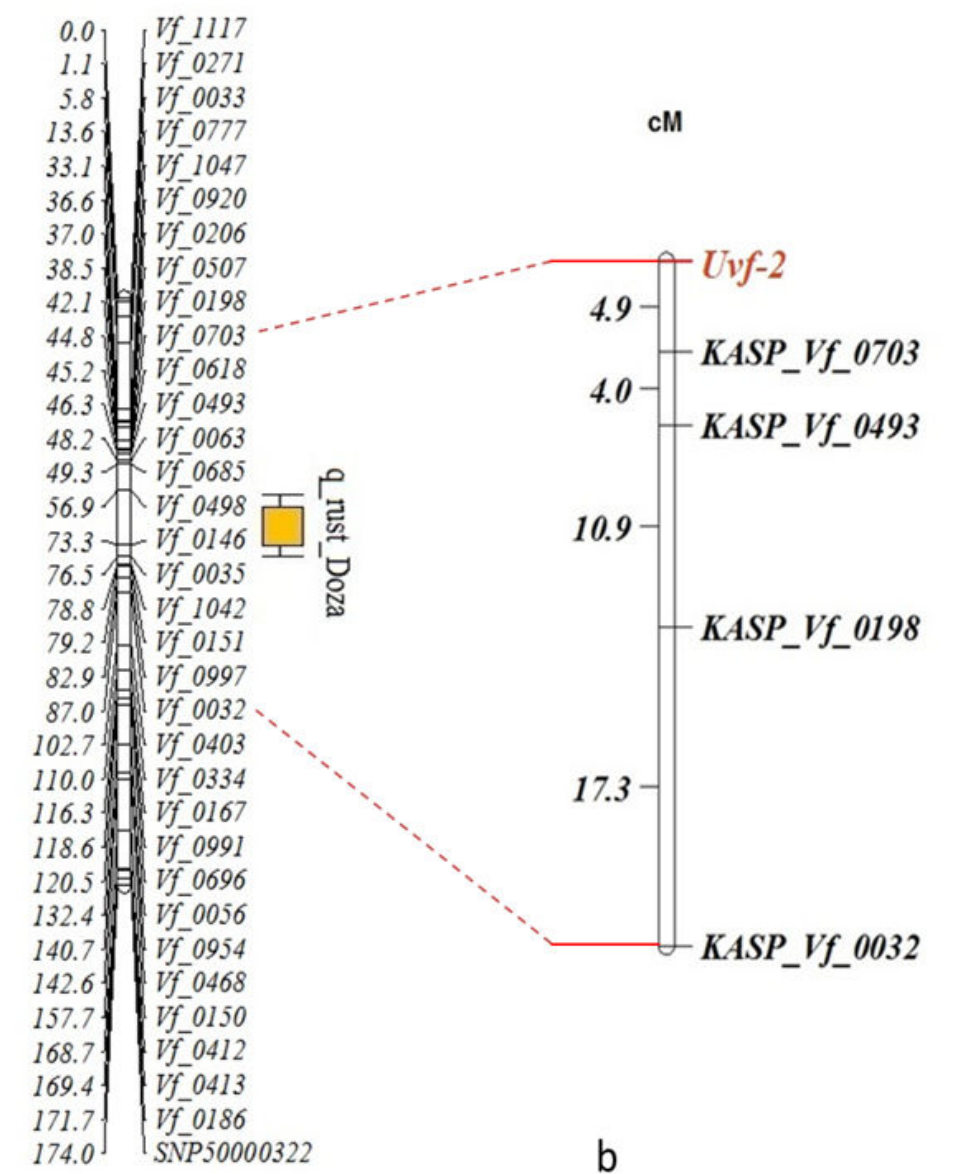
Figure 2. Linkage maps of chromosome III of the Fiord/Doza#12034 RIL population: ( a ) location of QTL for rust resistance in F 4 and ( b ) association of KASP markers converted from SNP in the QTL region with rust resistance gene Uvf-2